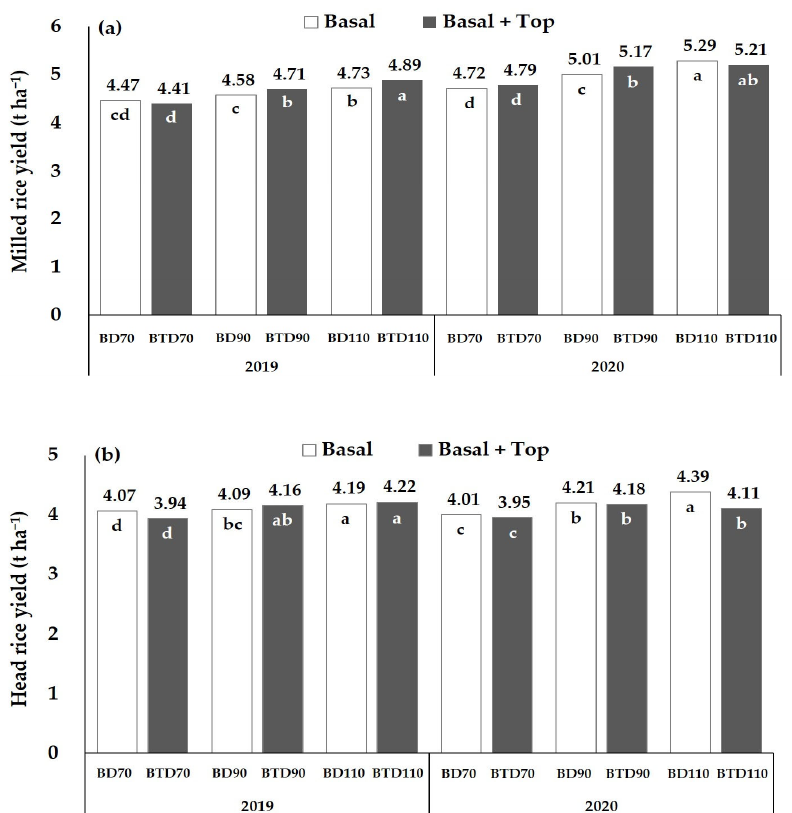
Figure 3. Milled rice yield ( a ) and head rice yield ( b ) according to nitrogen application methods. Means with the same letters in 2019 and 2020 are not significantly different at 5% level as determined by Duncan’s multiple range test.